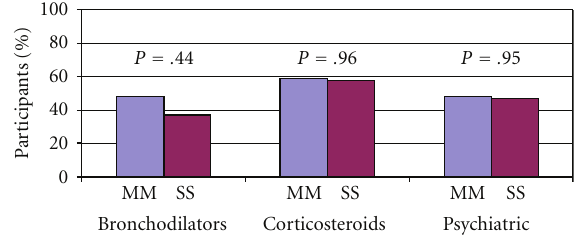
Figure 2: Lifetime medication use percentage in the study cohort ( N = 19) compared to the controls ( N =